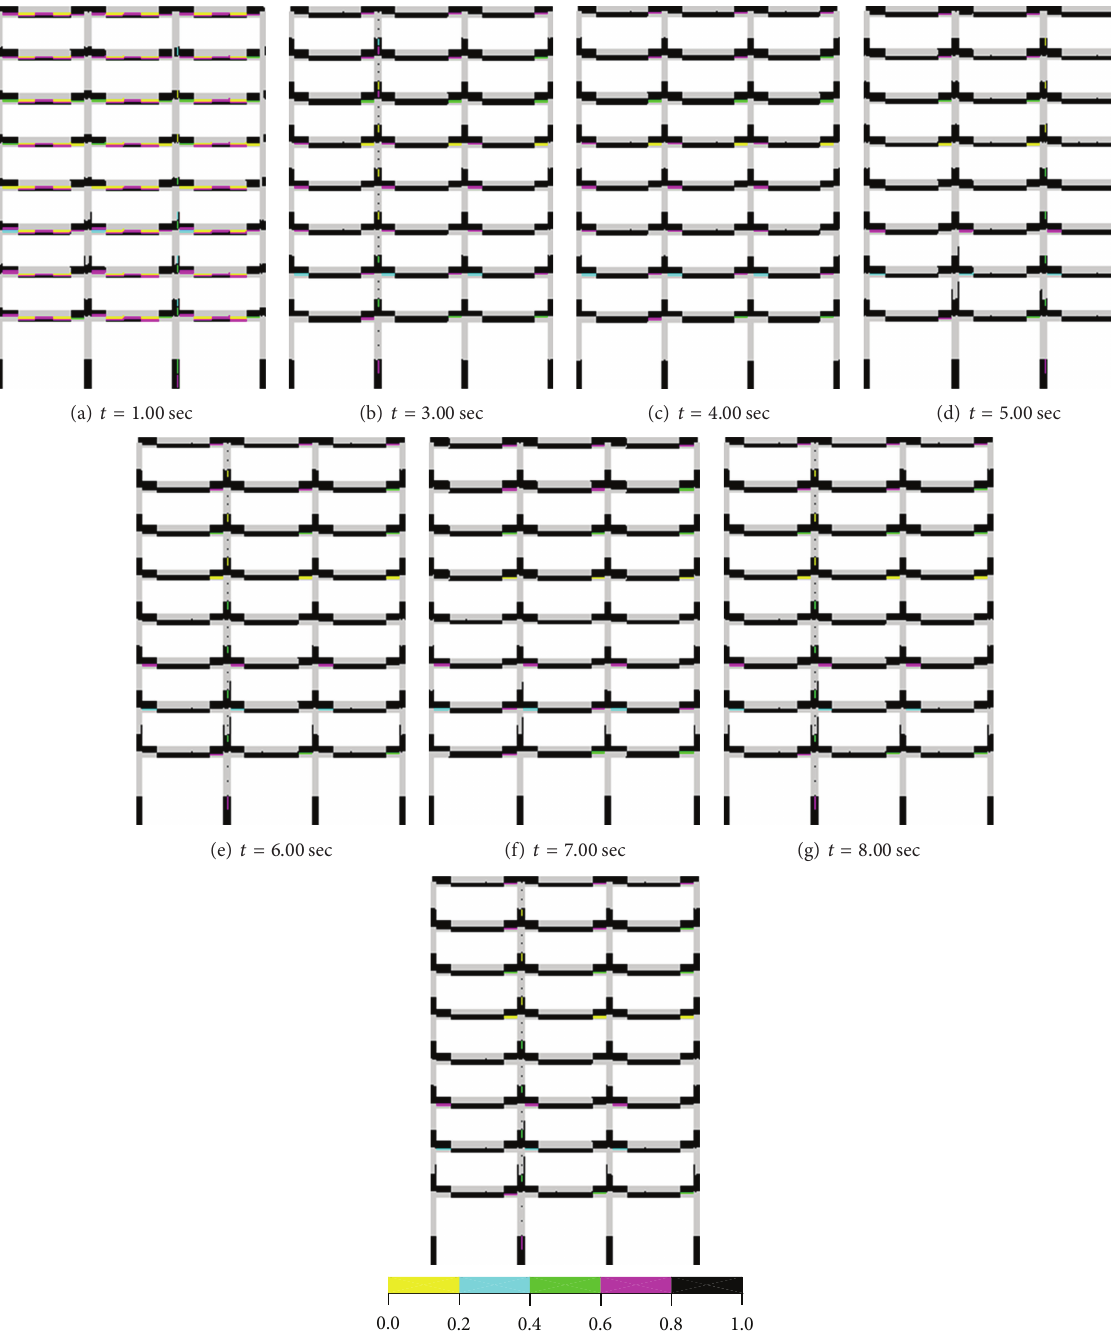
Figure 13: Accumulated damage zones in building for distributed mass/loading